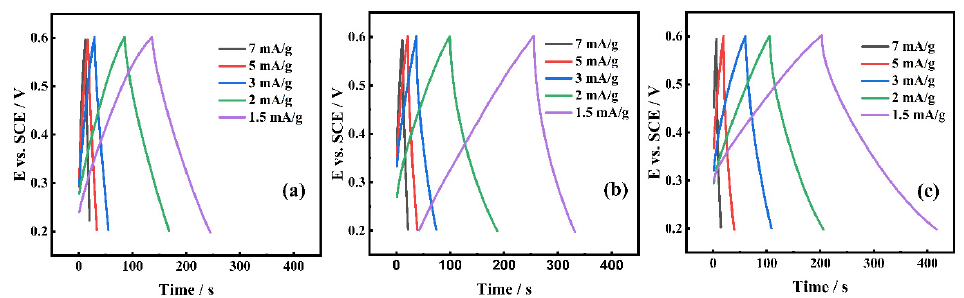
Figure 11. Effect of current density on the GCD curves of ZnMn 2 O 4 spinel produced for ( a ) 6 h, ( b ) 12 h, and ( c ) 18 h.